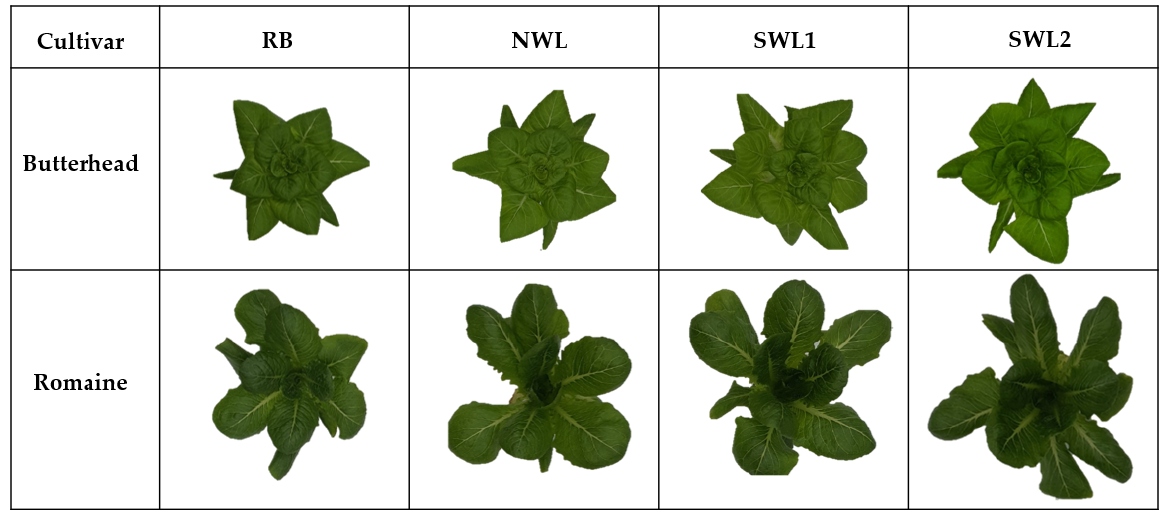
Figure 2. Butterhead lettuce and romaine lettuce grown under various light sources with the same electrical power after 4 weeks of transplanting.